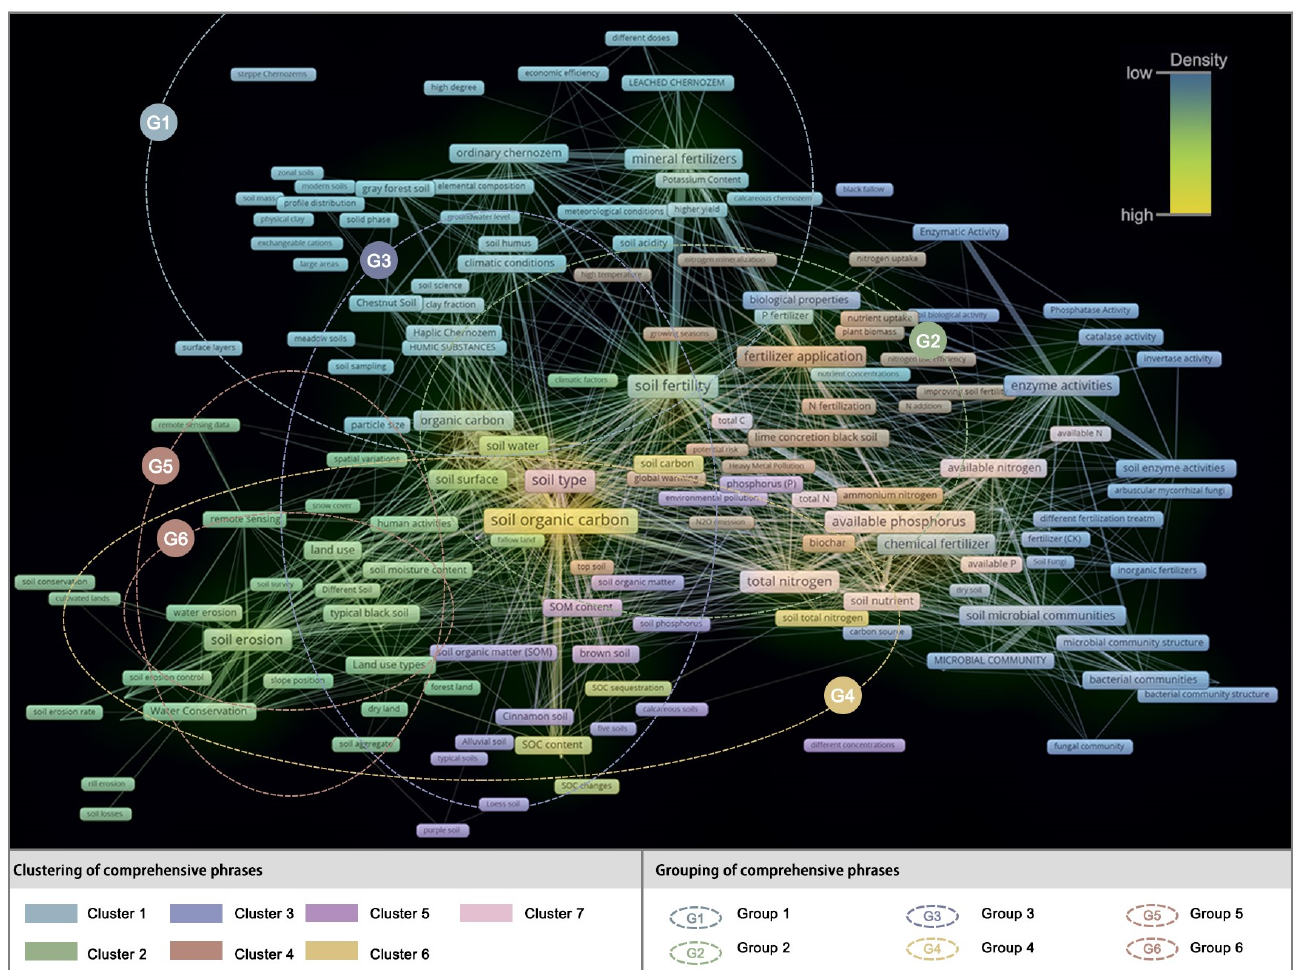
Figure 6. Four main research domains are distinguished according to the keyword network: soil erosion and ecological processes, fertilizer management and element cycling, soil microbial community and activity, and soil organic matter. Table 2. Clustering and grouping of comprehensive phrases.